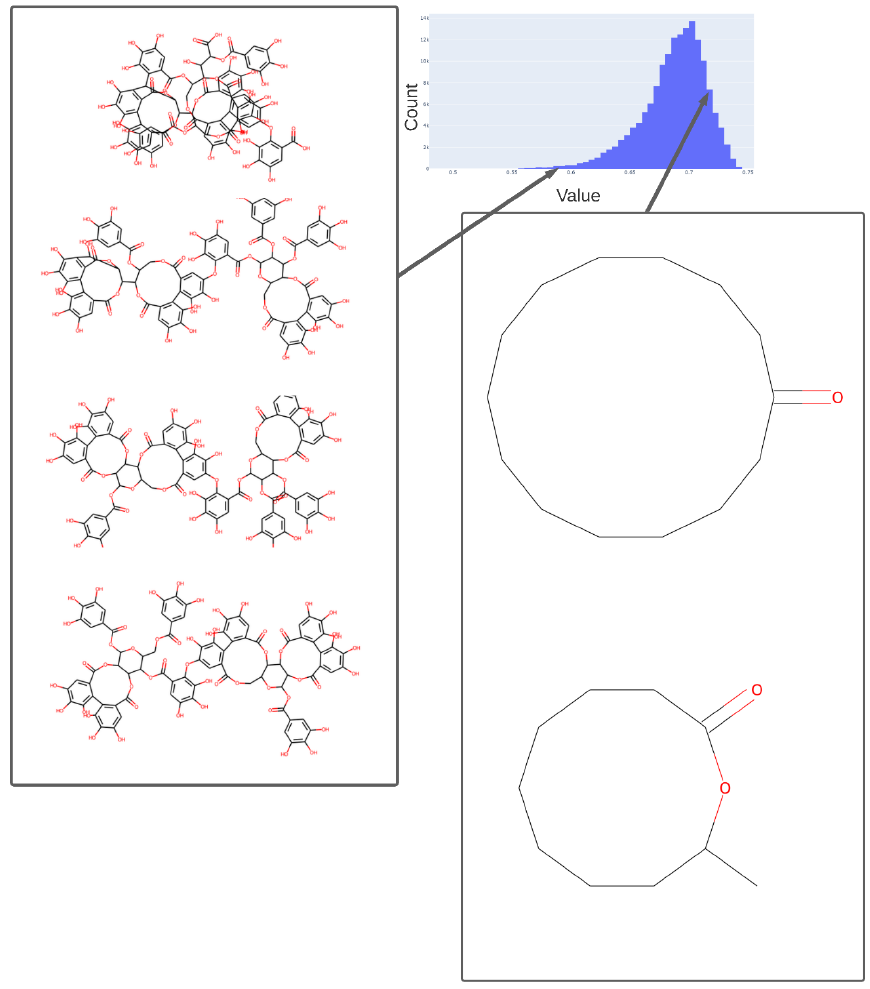
Figure 5. Values adopted in dimension 254 of the trained 256-D transformer, showing the values of various tri-hydroxy-benzene-containing compounds (left) ca. 0.59 and two lactones (ca. 0.73). The arrows indicate the bins (0.58, 0.73) in the histogram of values in this dimension from which the representative molecules shown were taken.